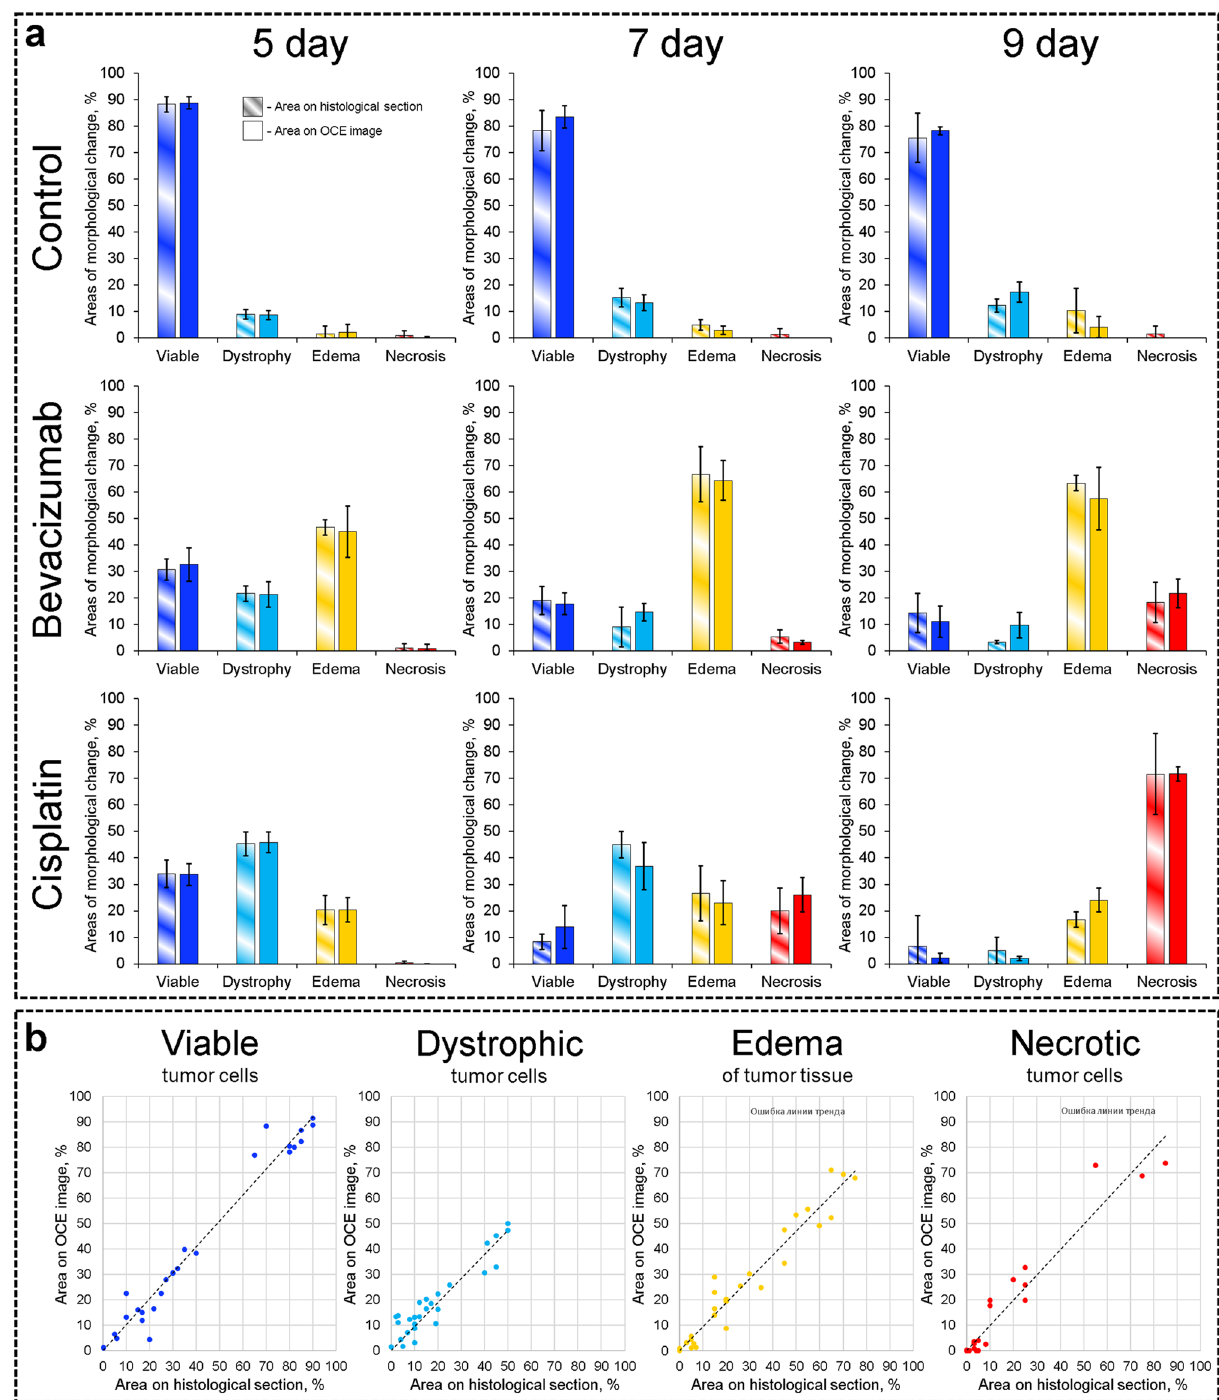
Figure 3. Quantitative comparison of histological and OCE-based segmentation results. ( a ) Comparison of the results of histological examination (striped columns) and OCE monitoring (monotone columns). ( b ) Relationship between the amount of space occupied by each allocated tumor zone and the percentage of the areas on the OCE images with a stiffness value in the range of this tumor zone. A strong and direct correlation is visible (Pearson correlation coefficient for viable tumor cells r = 0.98, for dystrophic tumor cells r = 0.94, for edema r = 0.97, for necrotic tumor cells r =